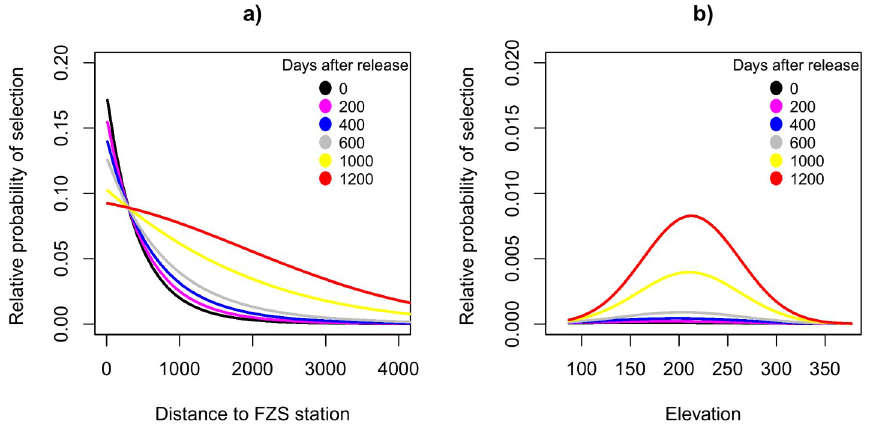
Fig 4. Orangutans adjust resource selection over time after release. Relative probability of selection in 32 orangutans (n = 13 females, n = 19 males) as a function of time after release (six different scenarios, in days) interacted with the distance to the FZS station (a, in meters), and elevation (b, in meters). The lines represent the average relative probability of selection as predicted by the resource selection function.